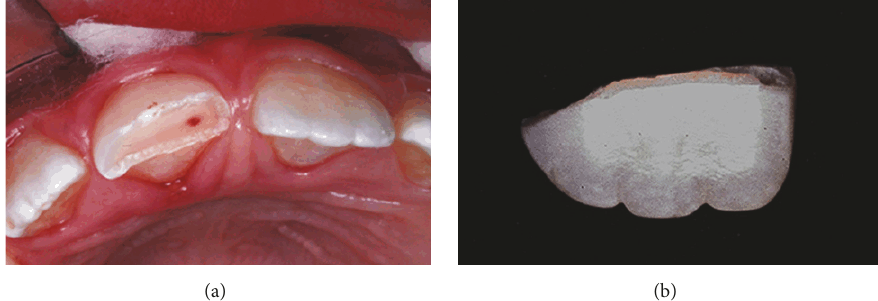
Figure 2: Clinical aspects of the pulp exposure (a). Original tooth fragment recovered at the accident site and stored in milk (b).